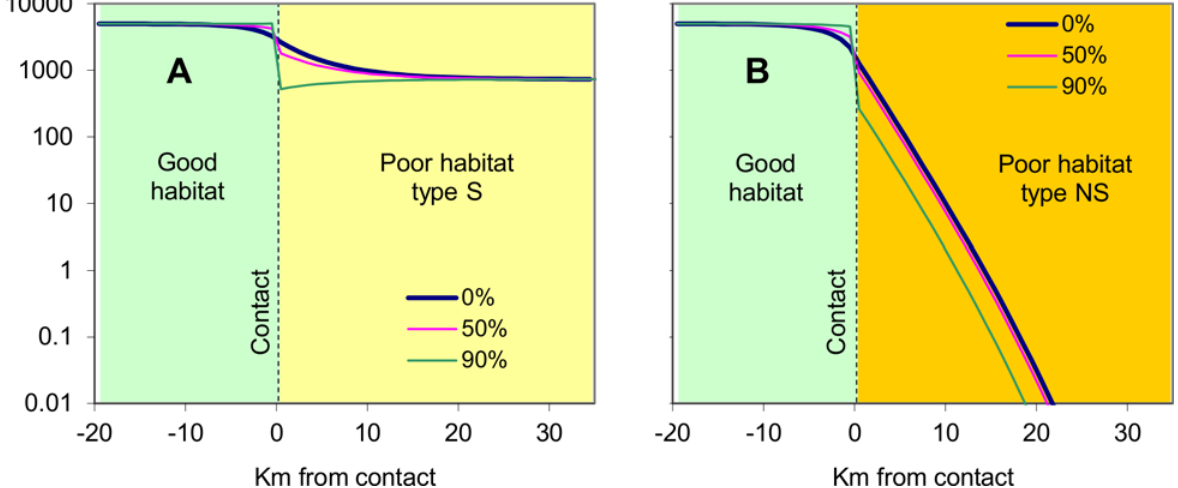
Fig 2. Population distribution associated with adjoining habitats involving reflective contacts. Abundances of adult female tsetse at various distances from the contact between good and poor habitats when the poor habitat was type S (A), or type NS (B), with reflectances of 0%, 50% and 90%. Reflectance applied only when the flies were heading towards the poor habitat.